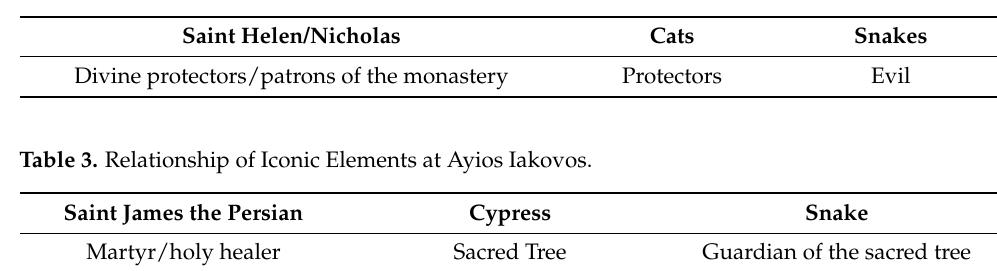
Table 2. Relationship of Iconic Elements at Ayios Nikolaos in Akroteri.